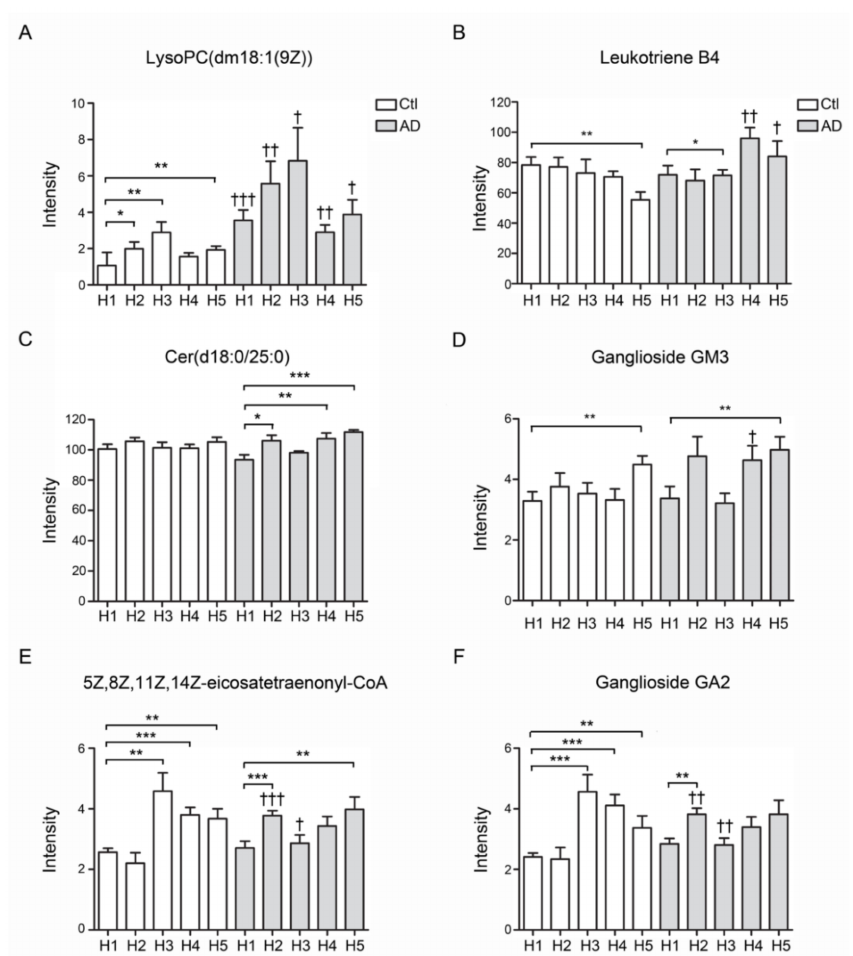
Figure 5. Lipidomics analysis of HDL form AD patients and controls. ( A ) LPC (dm18:1(9Z)) was significantly increased in all subfractions of AD-HDL in comparison with Ctl-HDL. ( B ) Eukotriene was significantly decreased in the H5 of Ctl-HDL. ( C ) Cer(d18:0 / 25:0) ceramide was elevated in H4 and H5 of AD-HDL in comparison with H1. ( D ) Ganglioside GM3 was elevated in the H5 of AD-HDL and Ctl-HDL subfractions. ( E ) Eicosatetraenonyl-CoA was elevated in H3–H5 from Ctl-HDL and H2 and H5 from AD-HDL. ( F ) Ganglioside GA2 was enhanced in H3–H5 from Ctl-HDL and H2 and H5 from AD-HDL. * p < 0.05, ** p < 0.01, *** p < 0.001: comparison to H1 of either AD patients or controls; † p < 0.05, †† p < 0.01, ††† p < 0.001: comparison between AD patients and